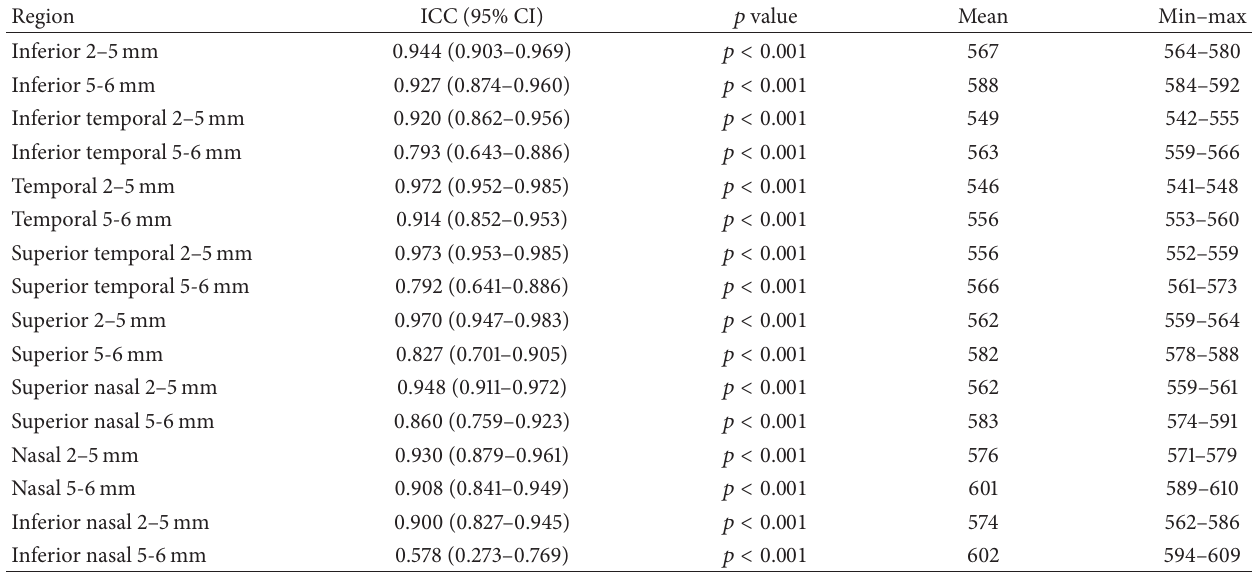
Table 4: Repeatability (ICC value) of peripheral corneal thickness measurement according to region.